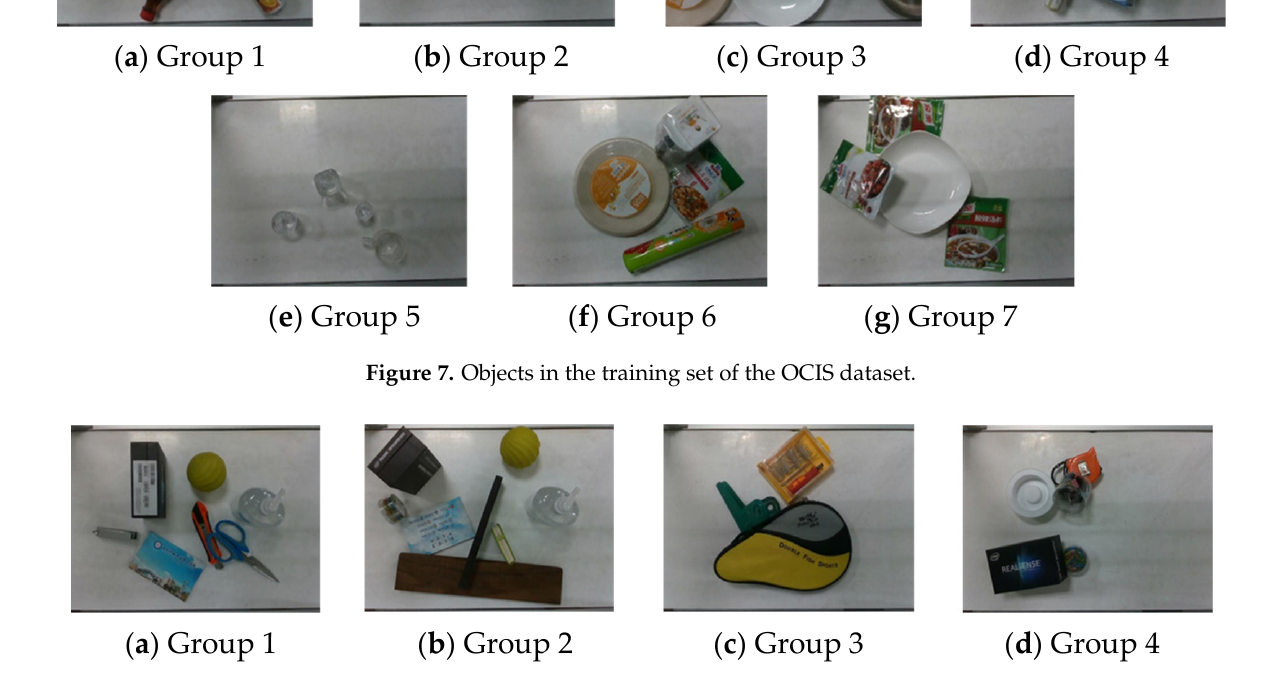
Figure 8. Objects in the test set of the OCIS dataset. Table 1. Distribution of the OCIS dataset.